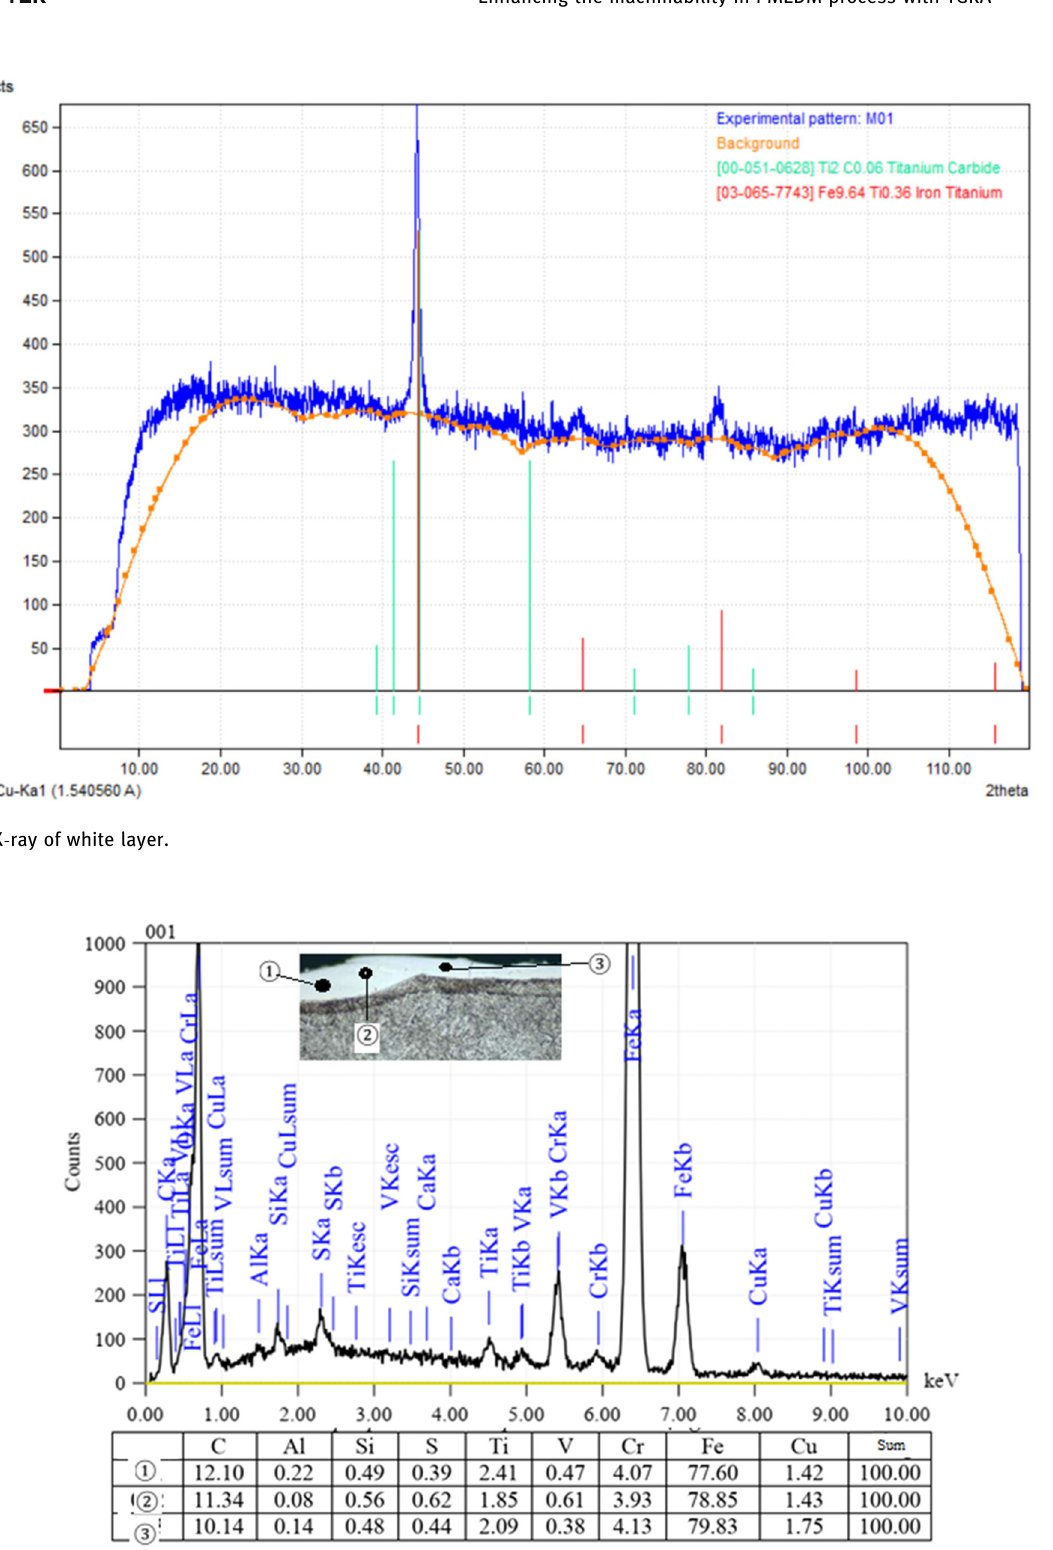
Figure 8: EDAX analysis of machined